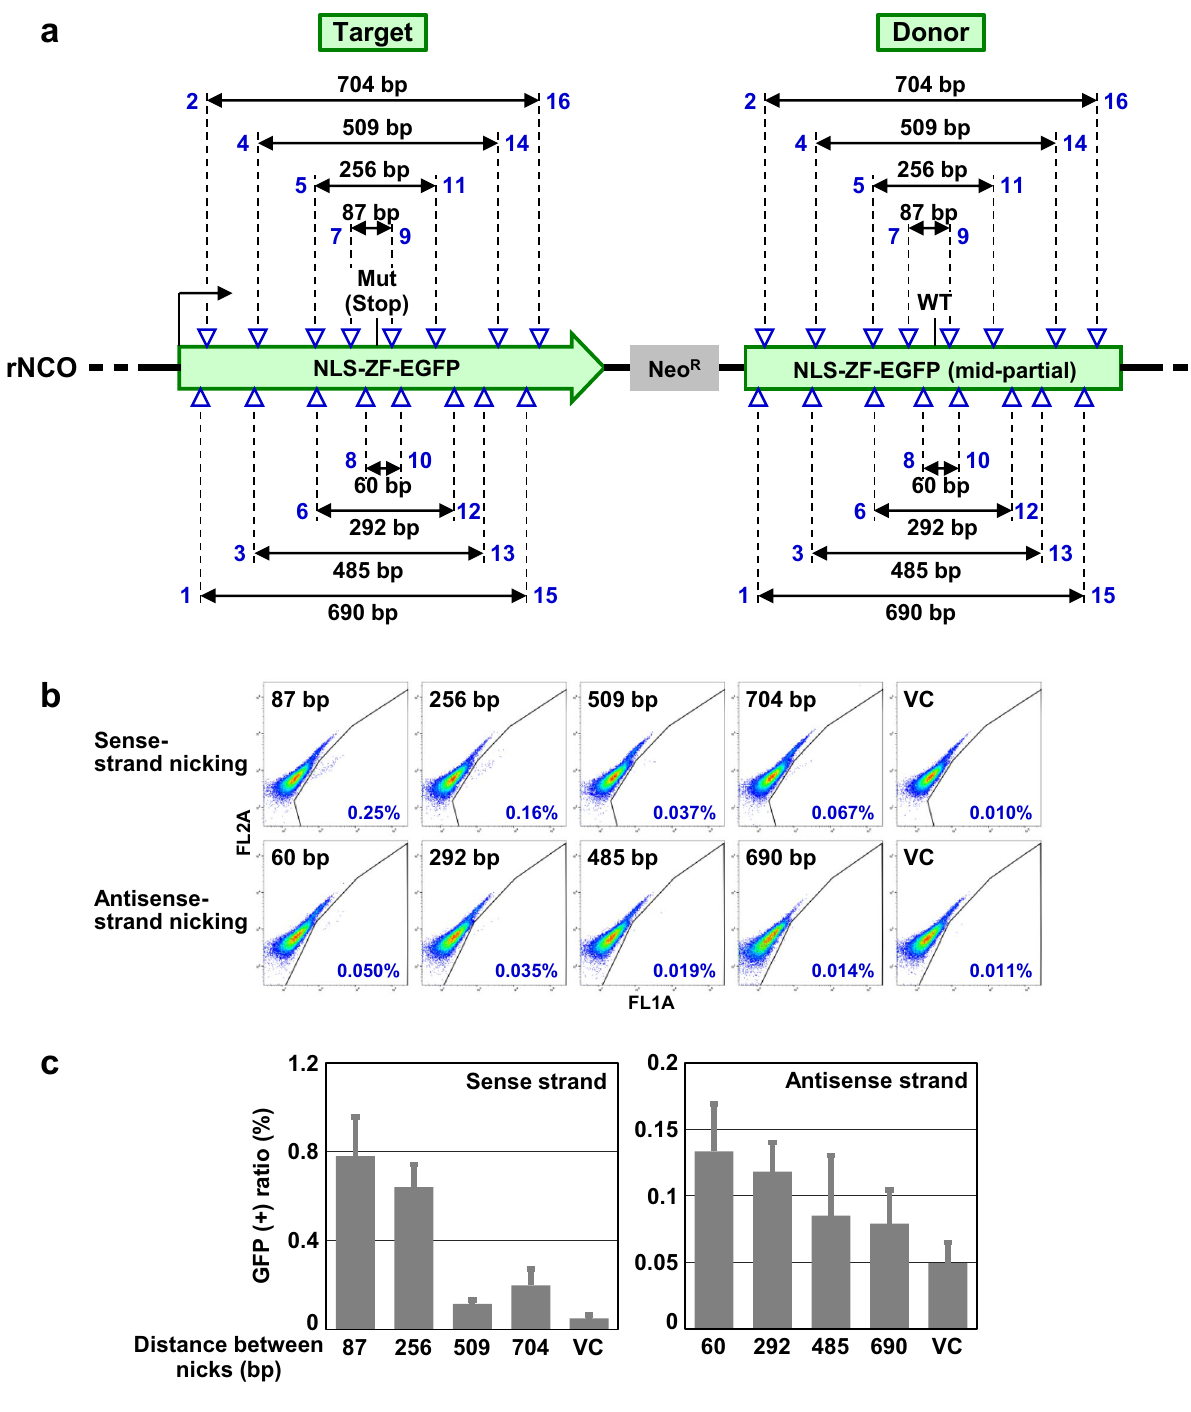
Figure 2. Shorter distance between two nicking sites promotes greater efficiency of targeted knock-in via TPN. (a) rNCO, a GFP-based reporter construct monitoring the incidence of intramolecular targeted knock-in. Targeted knock-in of the wild-type sequence within the “Donor” (right) into the mutated site within the “Target” (left) results in the reconstitution of a full-length wild-type EGFP. The numbers from 1 through 16 associated with triangles, from left to right, indicate the positions nicked by Cas9 nickases. NLS: nuclear localization signal; ZF: zinc finger; Neo R : neomycin resistance gene. (b) Representative dot graphs obtained in FCM analyses. (c) Graphical representation of the results. Data represent mean and SEM values from three independent